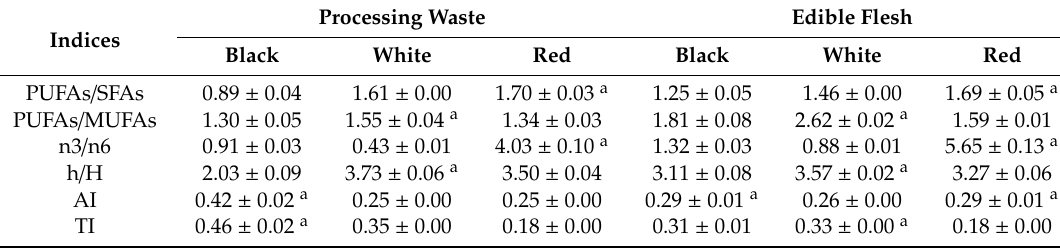
Values are mean ± standard deviation of percentages of the total fatty acids, from an average of three determinations. SFAs: total saturated fatty acids; MUFAs: total monounsaturated fatty acids; PUFAs: total polyunsaturated fatty acids; h / H: ratios of hypocholesterolemic (h) / hypercholesterolemic (H) fatty acids; AI: atherogenic index; and TI: thrombogenic index. a The mean value is significantly ( p < 0.05) highest among the processing waste or edible flesh obtained from black (black tiger), white (whiteleg), red (Argentine red)